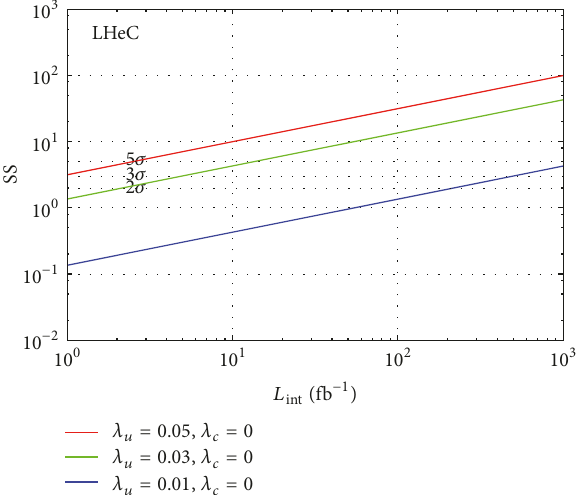
Figure 8: Invariant mass distributions of three jets (one of the jets is required as 𝑏 -jet) for the signal + background ( 𝑆 + 𝐵1 + 𝐵2 ) and backgrounds ( 𝐵1 , 𝐵2 ). The ratio plot presents the signal (for equal coupling scenario 𝜆 = 0.05 ) strength which peaks at the top mass. Table 4: The number of events for background 𝐵1 ( 𝐵2 ) and signal with FCNC couplings 𝜆 𝑢 and 𝜆 𝑐 at LHeC with 𝐿 int = 100 fb −1 .